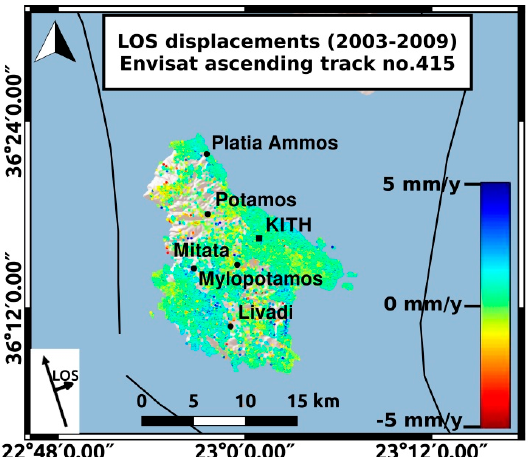
Figure 3. Mean line-of-sight direction (LOS) displacements for Envisat ASAR images—Ascending track no.